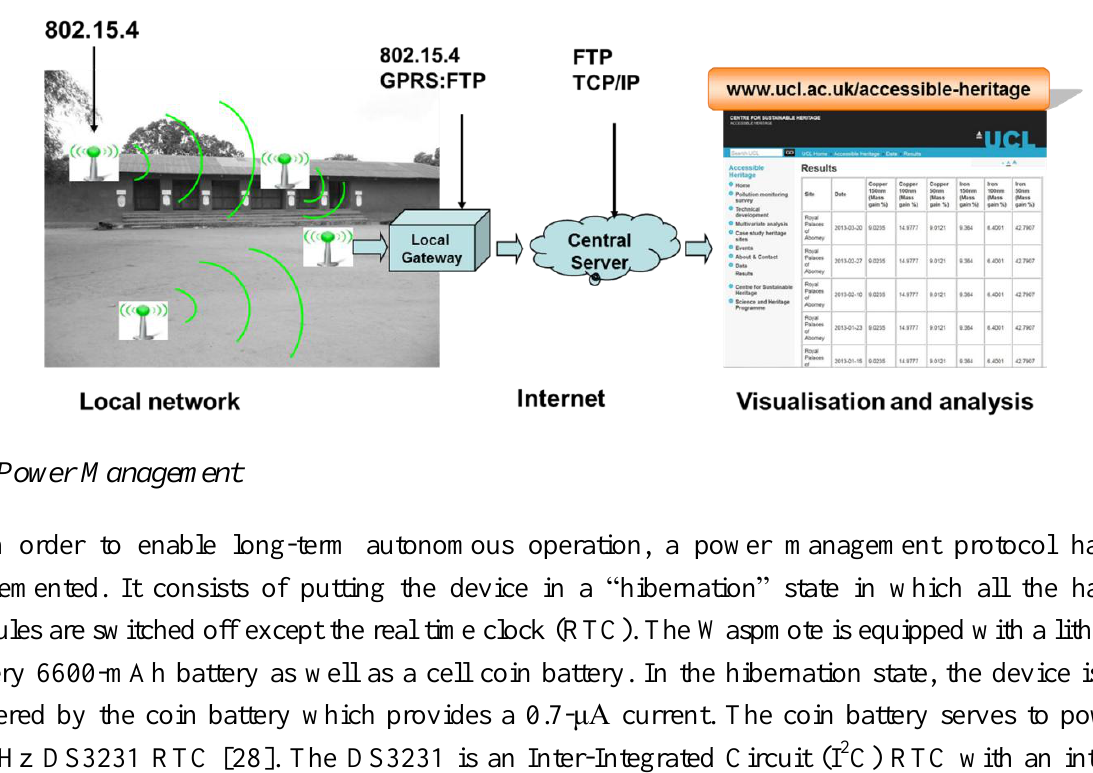
Figure 3. The communication